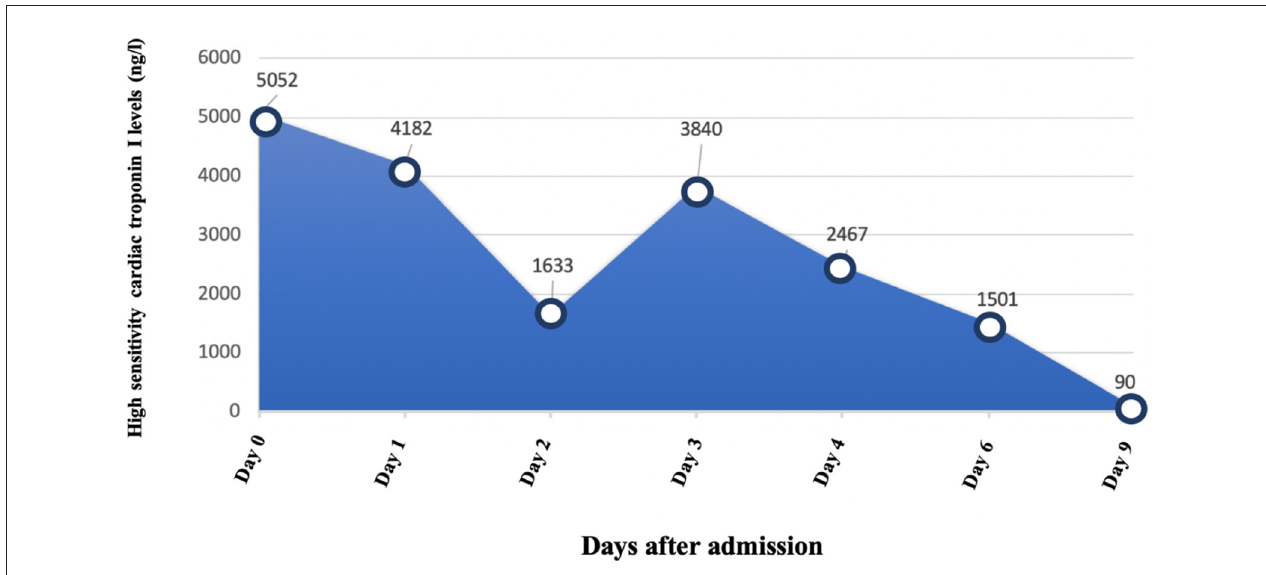
FIGURE 3 | Dynamic of high sensitivity cardiac troponin I levels. Hs-cTnI levels peaked at admission. Three days later, with ongoing recurrent episodes of chest pain, a further increase in hs-cTnI value was observed. After starting aspirin and colchicine, chest pain resolved and hs-cTnI levels progressively decreased. At discharge, hs-cTnI value was almost normal (normal range 0–58.05